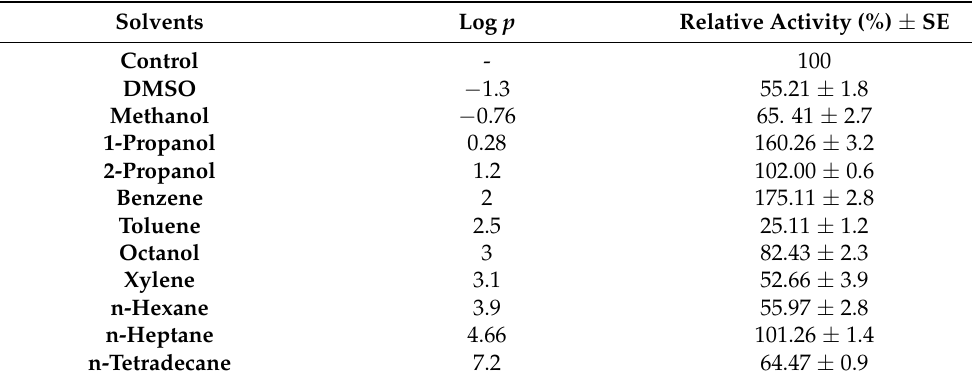
Table 4. Stability of purified A. geothermalis ALDH in the presence of various organic solvents. Solvents Log p Relative Activity (%) ± SE Control - 100 DMSO −